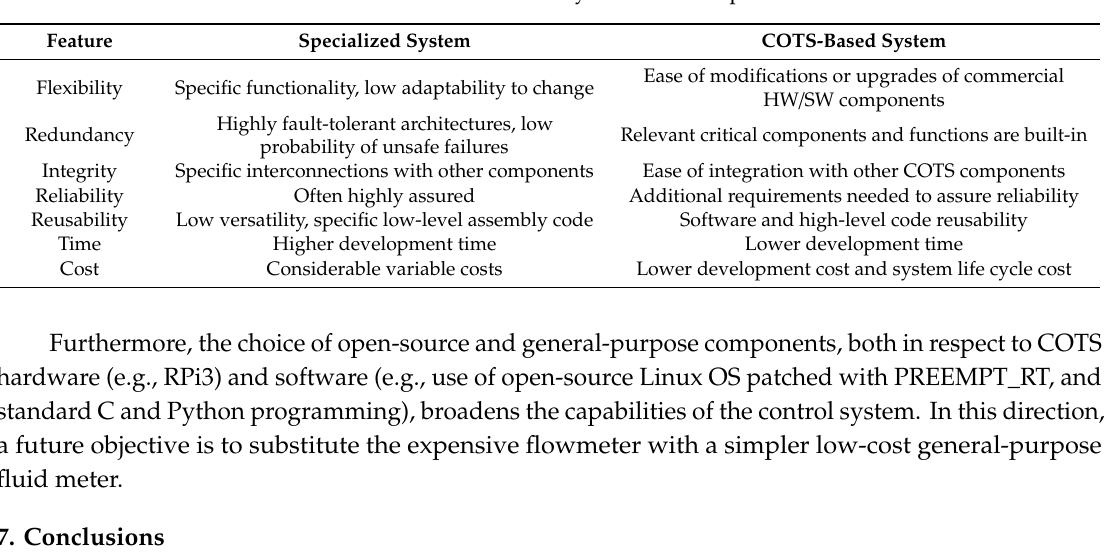
Table 2. Architectural features of COTS-based systems versus specialized or